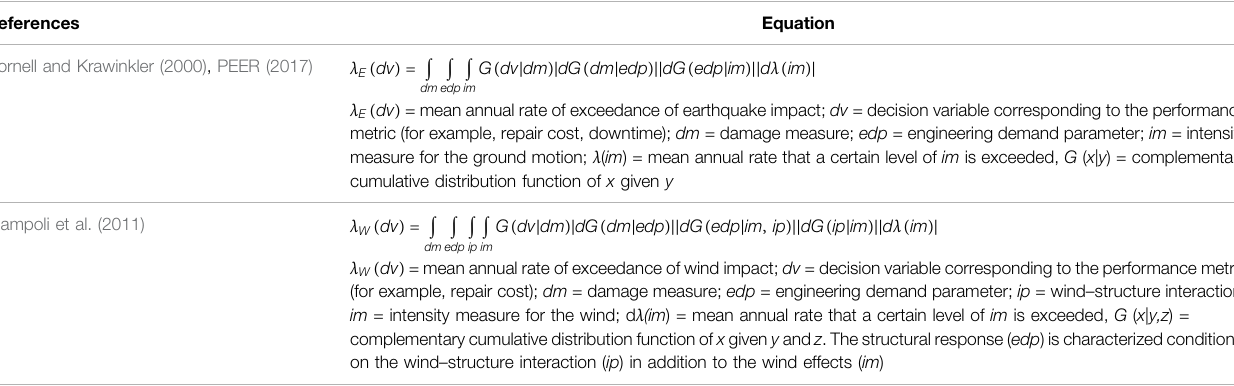
TABLE 1 | PEER performance based design framework.